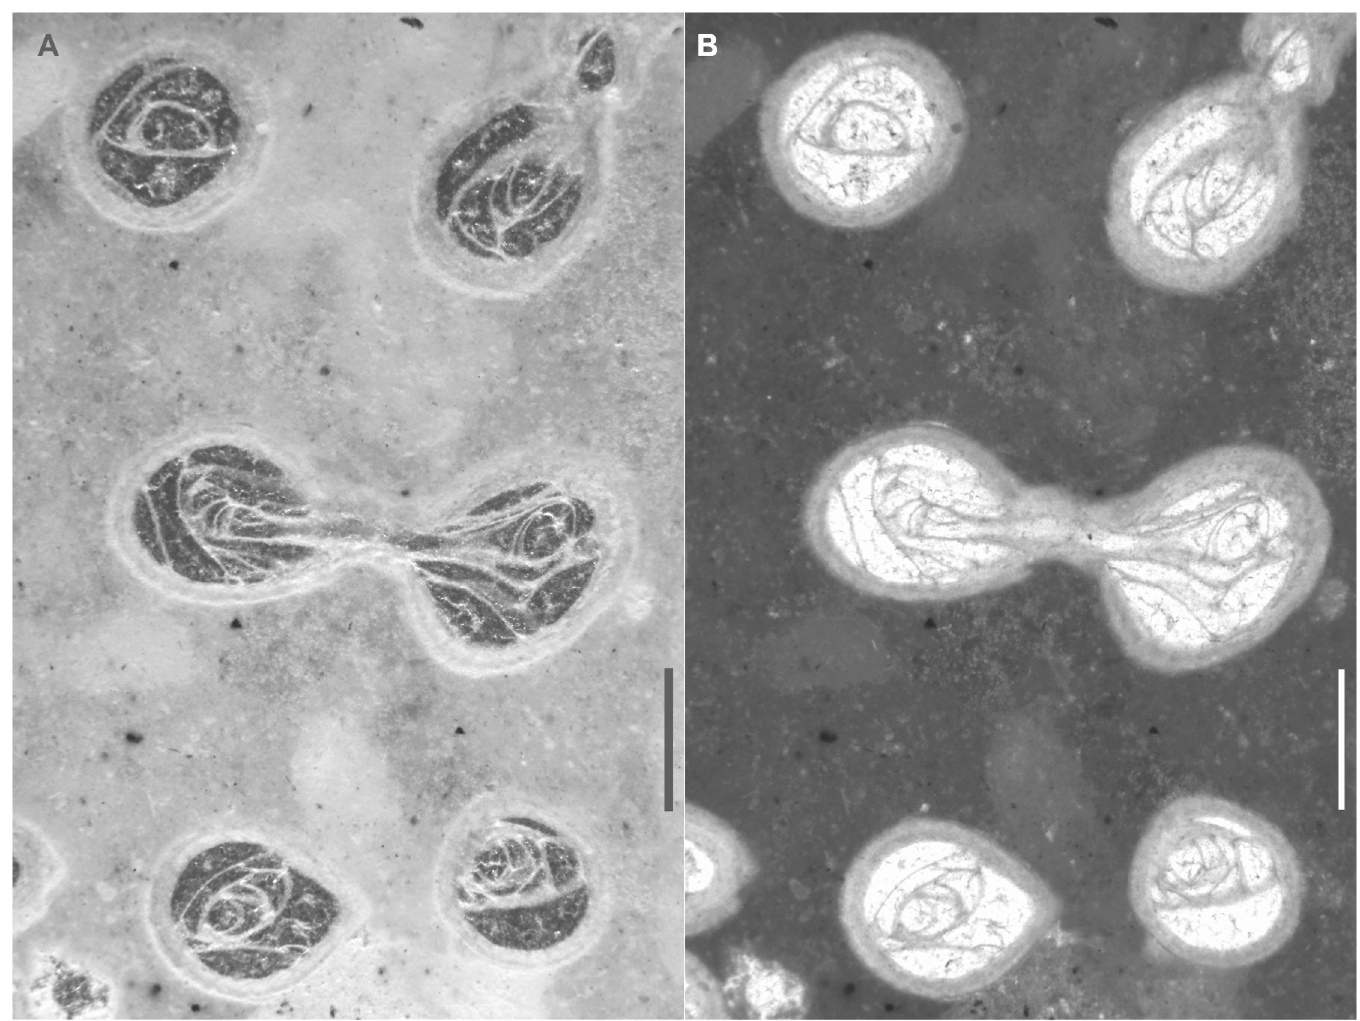
Fig 13. Syringopora hilarowiczi sp. nov. from Kowala Quarry, lithological set L, Upper Famennian. (A, B) Details of transverse sections. (A) Transmitted light. (B) Same section, dark field. Specimen GIUS 3619 KF 006, holotype.